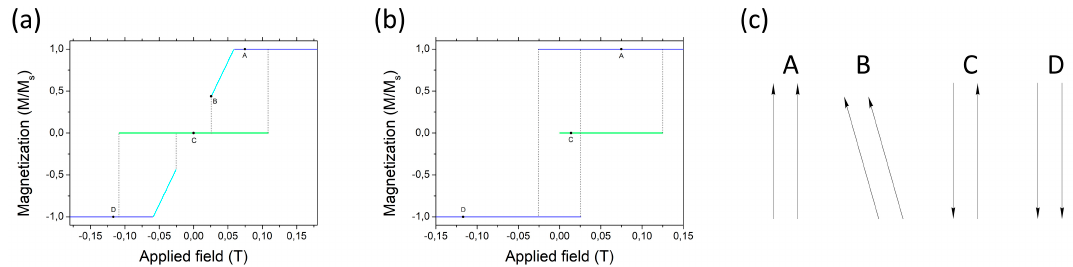
Figure 2. Magnetization sequence under the applied magnetic field in a S-W model of ( a ) stripes, ( b ) ellipsoids. The starting configuration for B = 0 is antiferromagnetic. Panel ( c ) represents the stages of magnetization switching in the case of the stripes marked with the letters A, B, C, D.